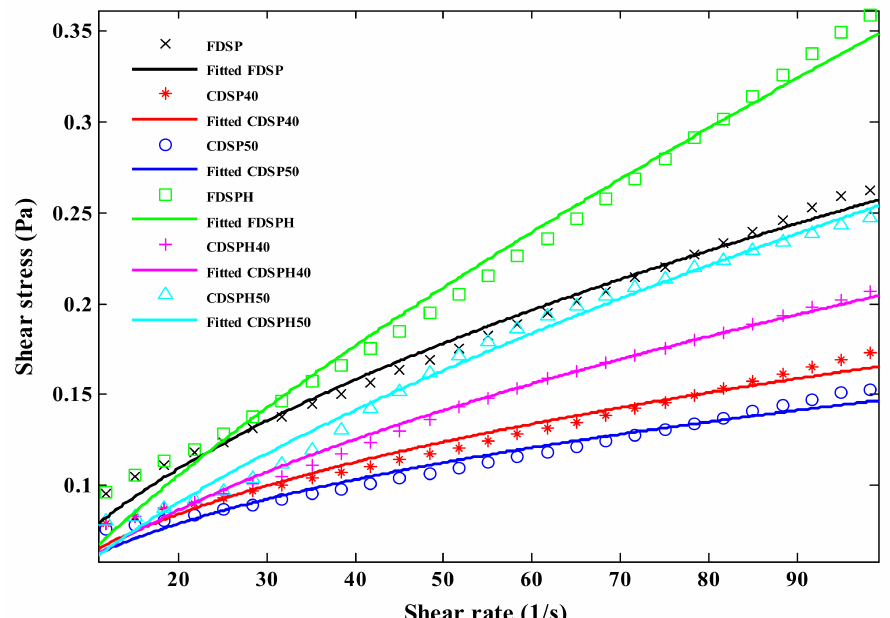
Figure 5. Values of shear stress against shear rate for freeze- and convectively-dried SP and